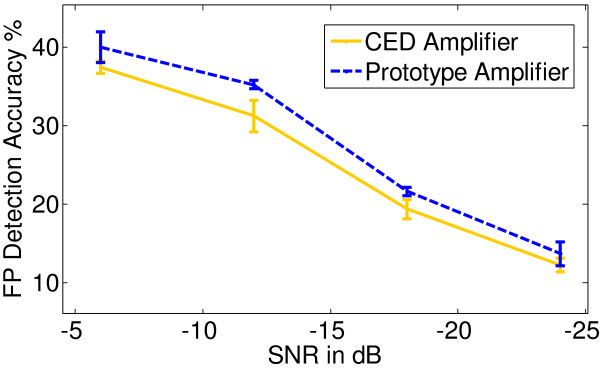
Prototype and OEM amplifier FP detection Vs SNR.